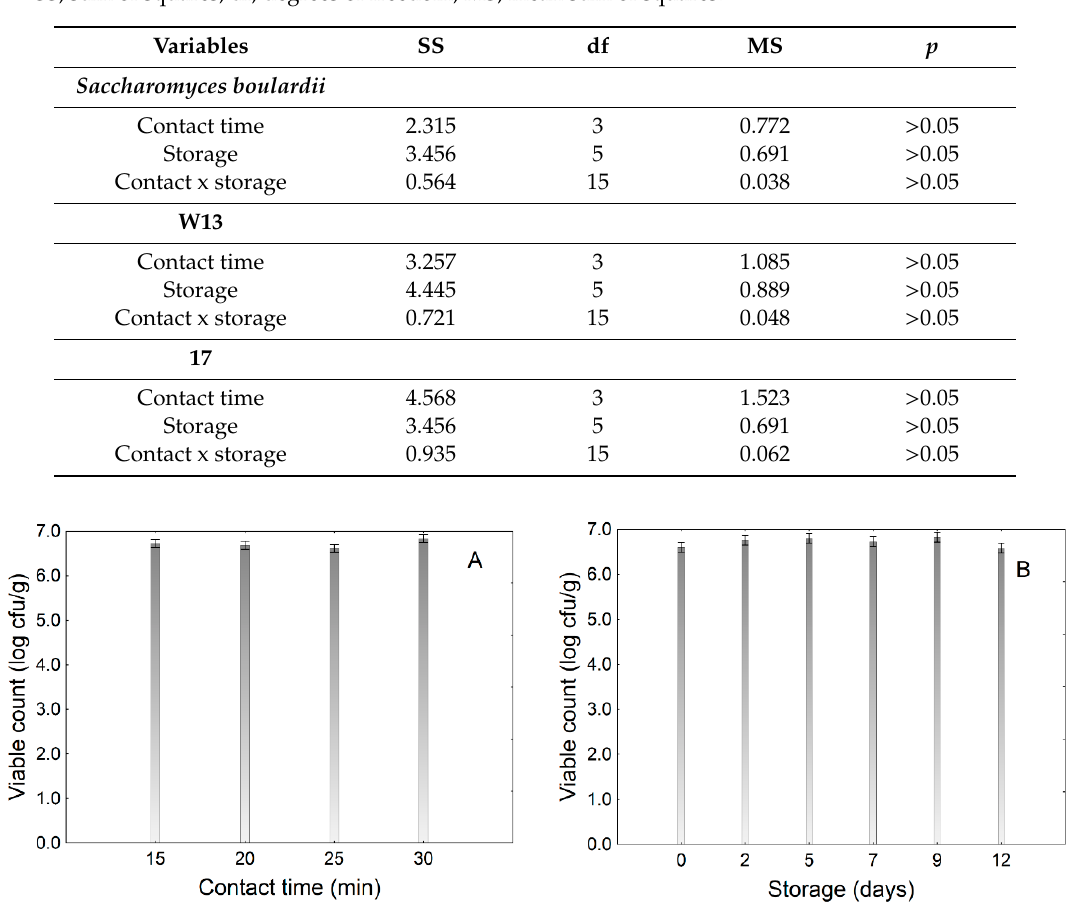
Table 1. Statistical e ff ects of the contact time of apple pieces in the mother solution (contact) and the duration of the storage at 4 ◦ C on the viability of yeasts. One-way ANOVA and Tukey’s test ( p < 0.05). SS, sum of squares; df, degrees of freedom; MS, mean sum of squares.